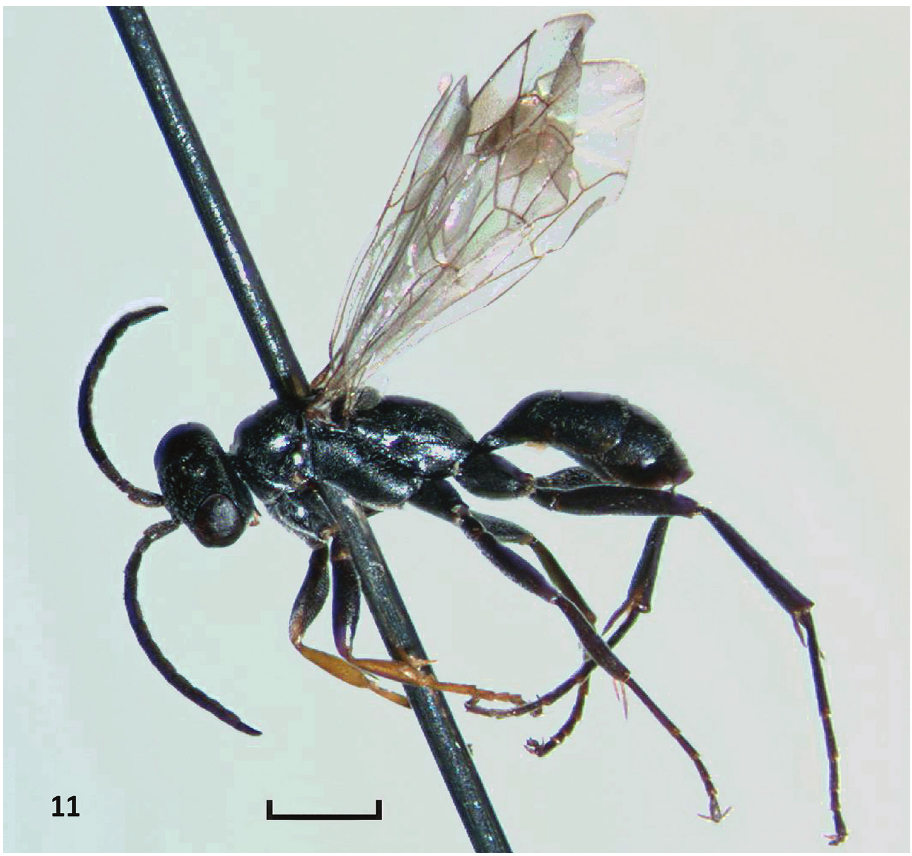
Figure 11. Nipponodipogon orientalis Loktionov, Lelej & Xu, sp. n., male, paratype, habitus, lateral view. Scale bar 1